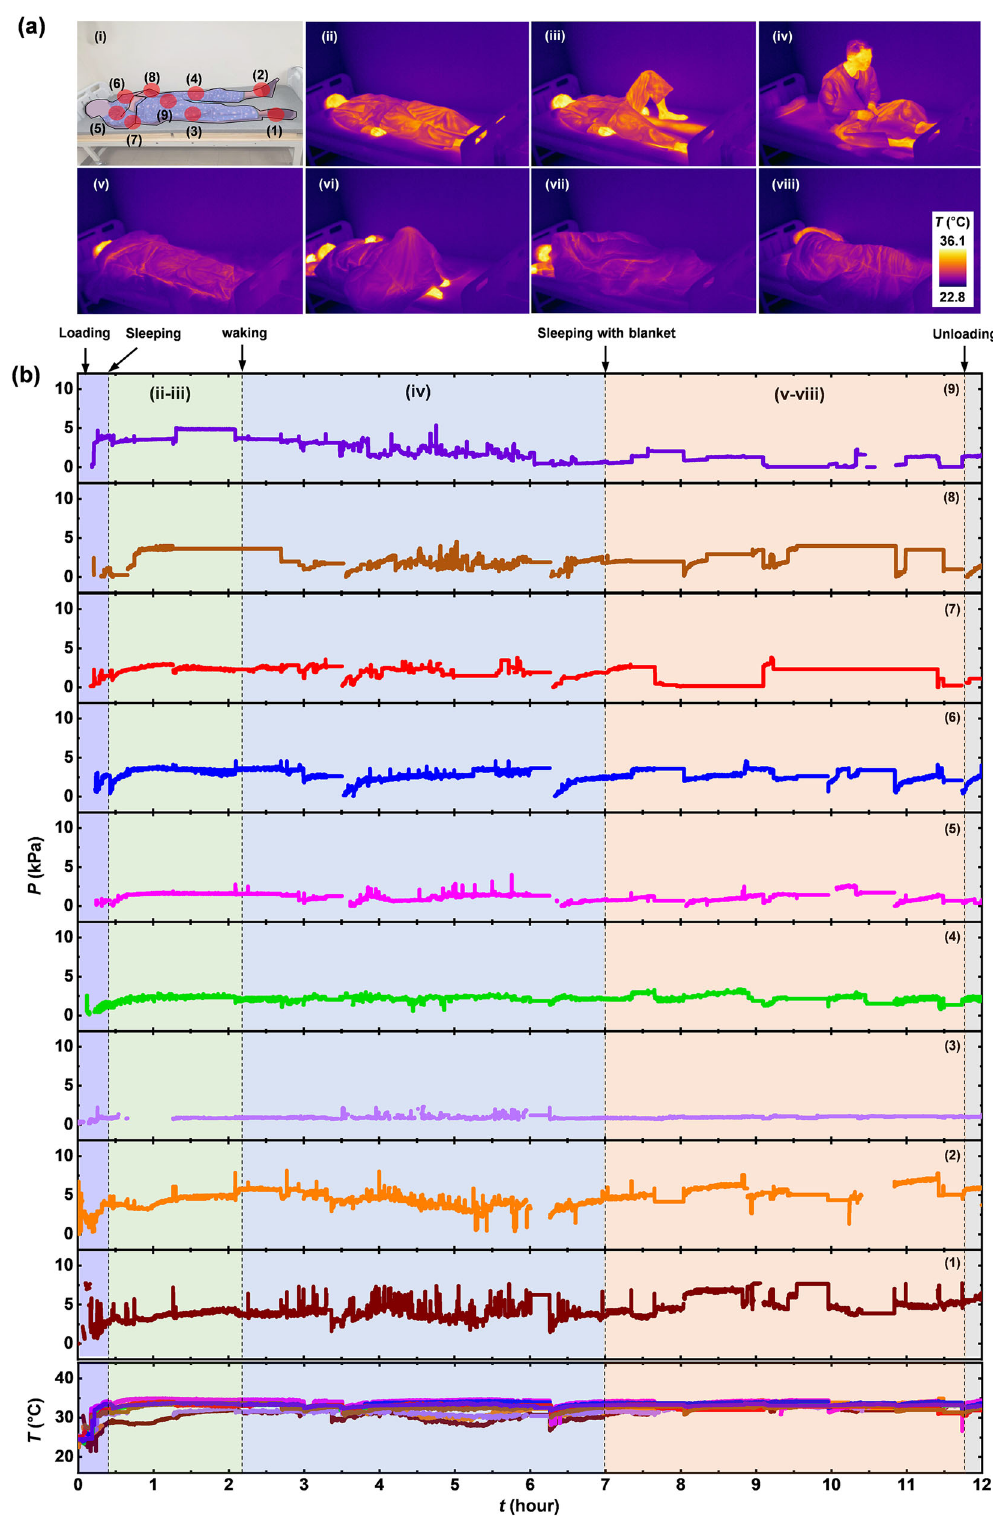
Fig. 6 Continuous measurements of pressure and temperature from a healthy subject (30-year-old male, 72 kg, 180 cm) using the wireless-sensing platform during an extended period of time. a Photograph of the subject with red discs to mark the mounting locations of the sensors and IR images of changes in posture of the subject lying on bed during biphasic sleep. b Results from continuous measurements of pressure and temperature from each of the